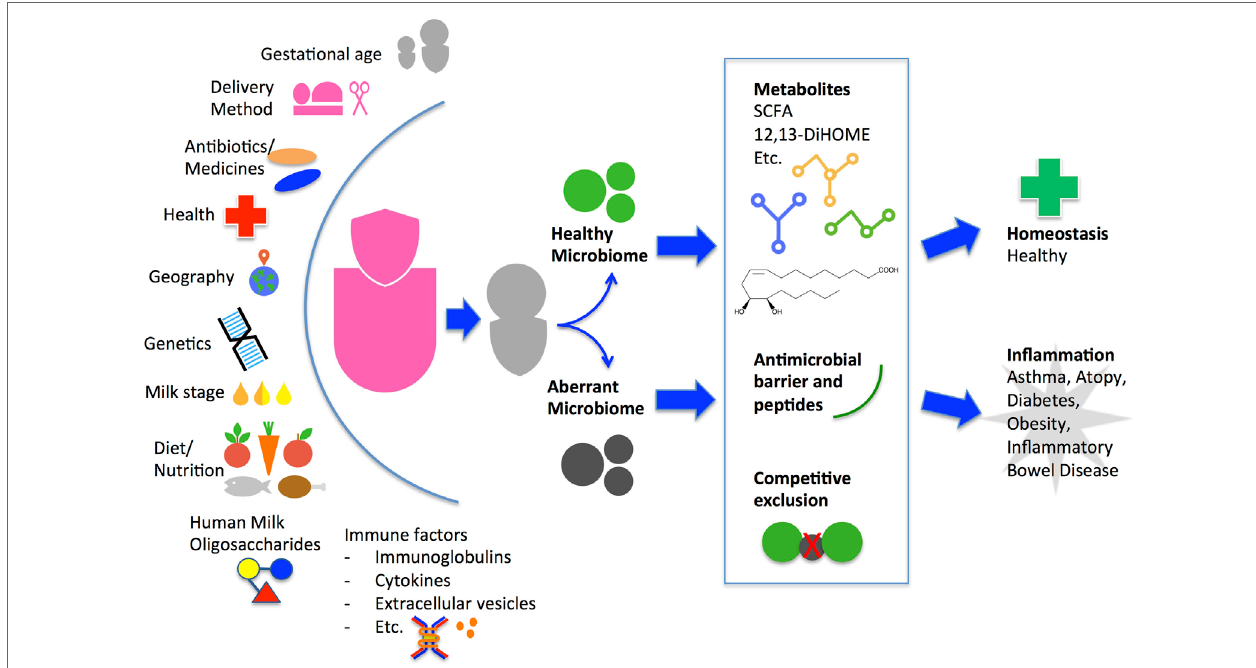
FiGURe 1 | Factors that influence maternal breast milk microbiome and proposed mechanism of how breast milk may alter the infant gut microbiome and health outcome. A myriad of environmental, genetic, and immune factors personalize a mother’s milk for delivery to her infant. Starting from the initial feeding, the breast milk microbes and human milk oligosaccharides contribute to the composition and diversity of the infant gut microbiome. The initial gut microbes may continue to promote colonization of a healthy community or an aberrant community. During the critical window of immune development, the community types may induce metabolic alterations leading to differing immune phenotypes and long-term health outcomes. SCFA, short-chain fatty